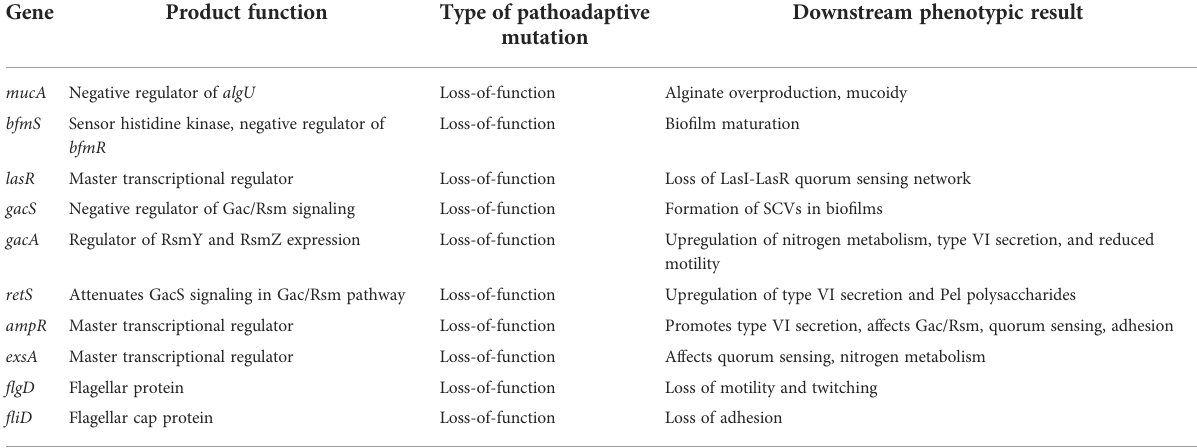
TABLE 2 Summary of genes targeted for convergent evolution in the CF lung during CRI with Pa, catalyzed by